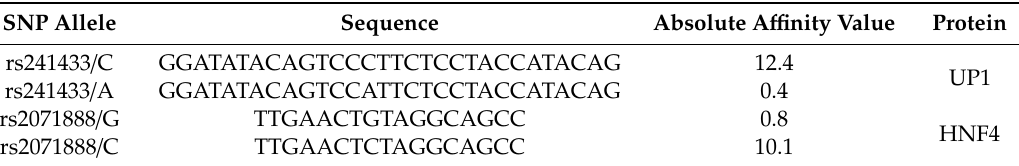
Table 4. Sequences and a ffi nity for di ff erent